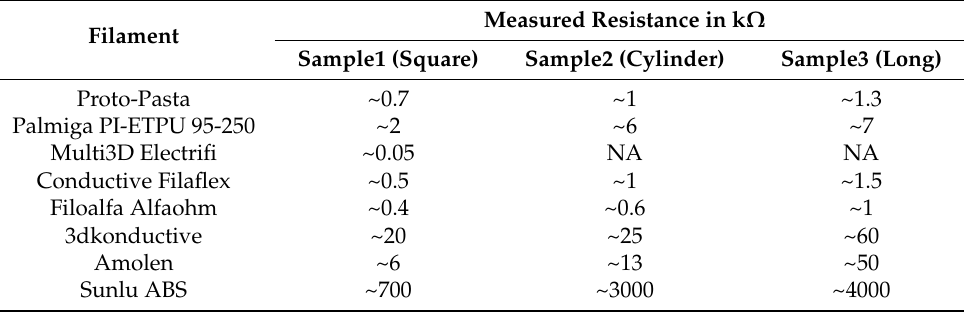
Figure 1. Printed samples of the following conductive filaments: ( a ) Proto-Pasta; ( b ) Filoalfa Alfaohm; ( c ) Palmiga PI-ETPU 95-250; ( d ) Multi3D Electrifi; ( e ) Conductive Filaflex; ( f ) Sunlu ABS; ( g ) Amolen; ( h ) 3dkonductive. Table 3. Approximate values in k Ω of the measured resistance for printed